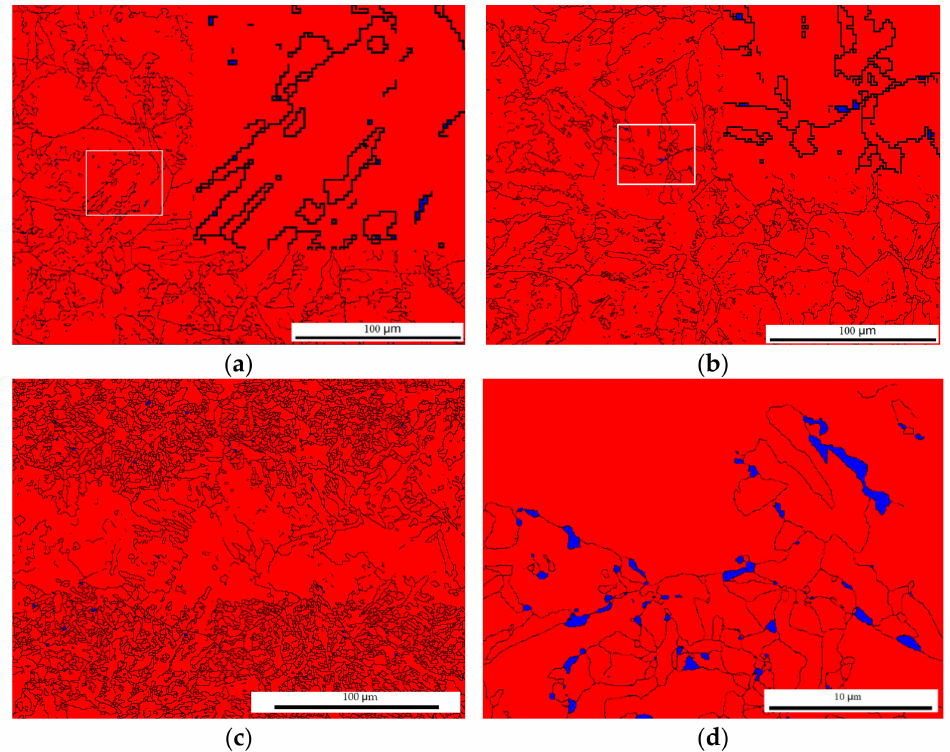
Figure 4. Phase image of the ( a ) as-welded; ( b ) typical; and ( c ) spotty cases and ( d ) magnification of ( c ).